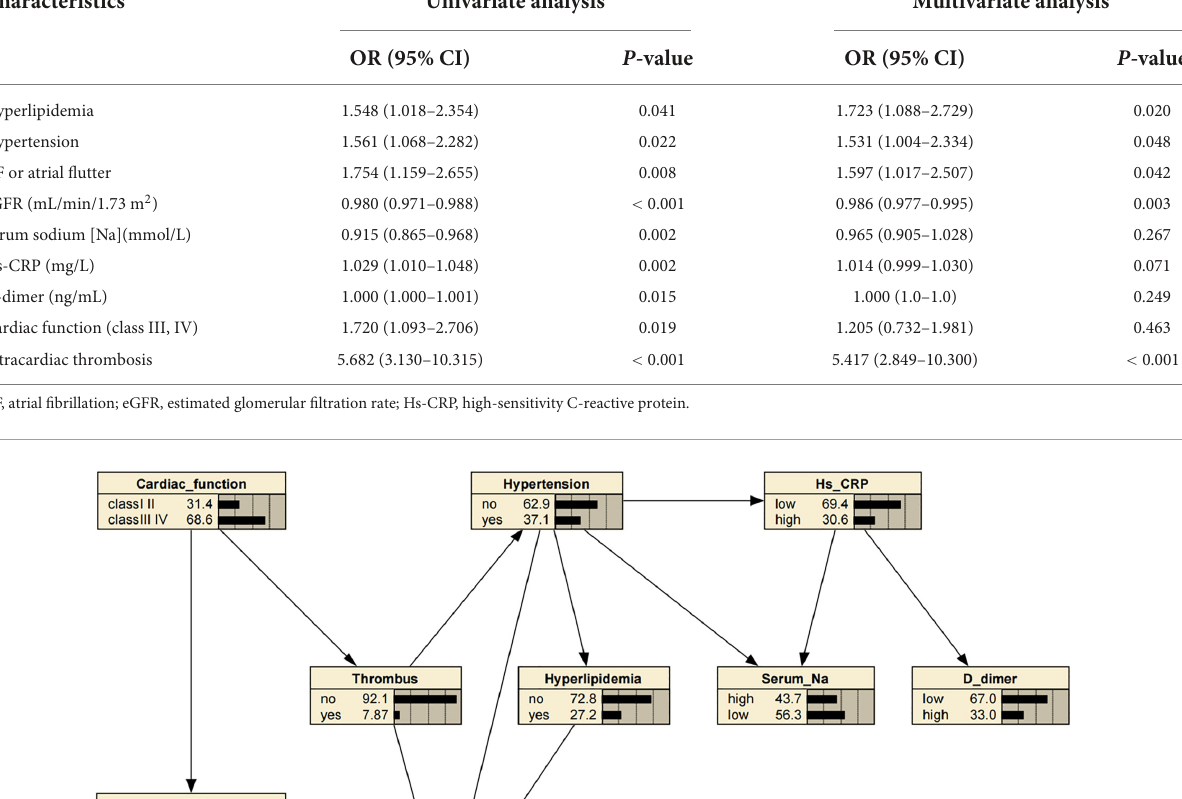
TABLE 2 Risk factors of ischemic stroke in patients with dilated cardiomyopathy (DCM): Univariate and multivariate binary logistic regression analysis. Characteristics